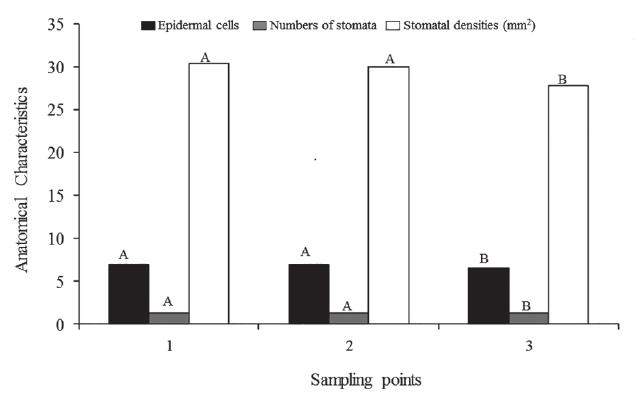
Fig. 2 - Numbers of epidermal cells, numbers of stomata, and stomatal densities of the leaves of T. pallida at the three sampling points. (Averages of the anatomical characteristics at the different sampling points followed by the same letter do not significantly differ according to the Tukey test at a 5% level of